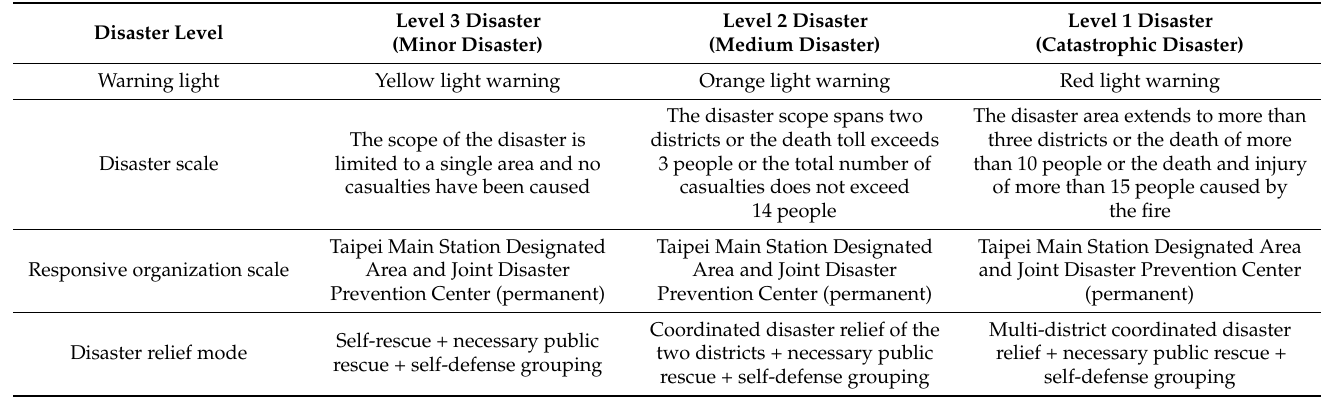
Table 7. Types of Disasters and Disaster Level Definitions in the Specific Areas of Taipei Main